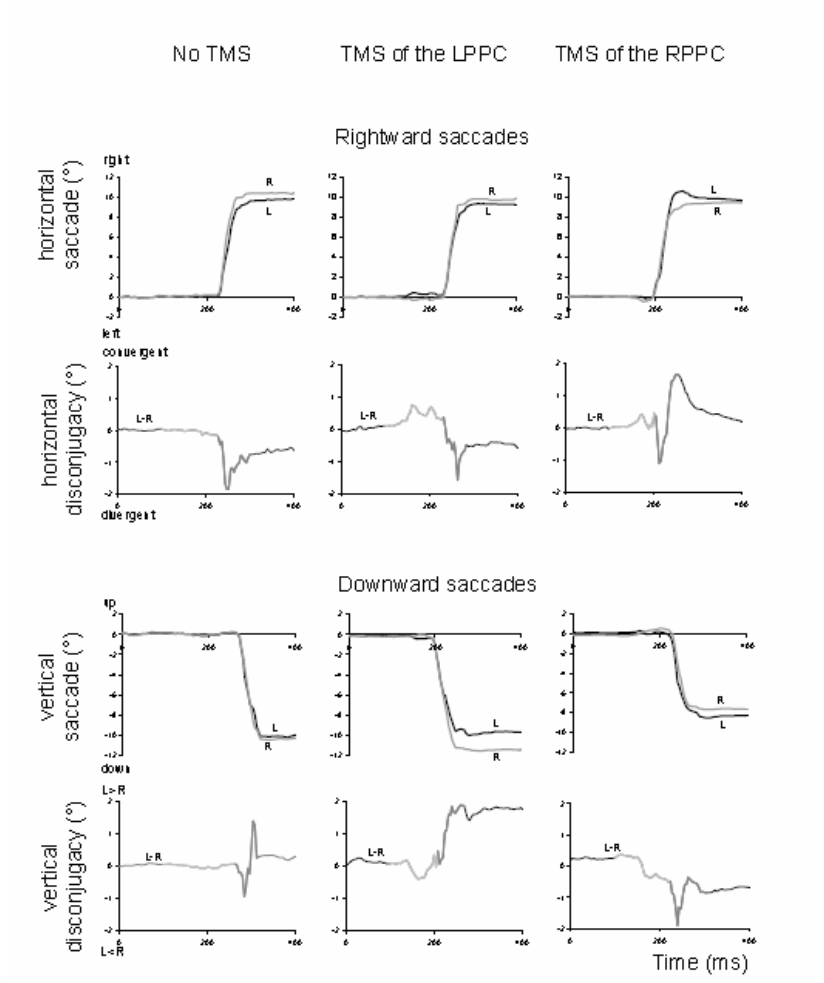
Figure 11. Sample traces during rightward (top) and downward (bottom) saccades for the no TMS condition, the left PPC stimu- lation and the right PPC stimulation. L: left eye; R: right eye; L-R: disconjugate component. The target appears at t = 0 ms. TMS is applied at t = 100